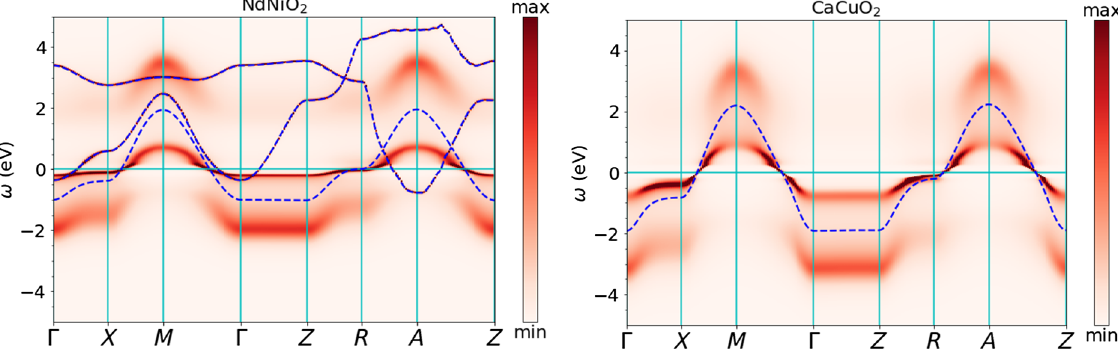
FIG. 4. Frequency dependence of the spectral function A ð k; ω Þ plotted along indicated lines in momentum space (false color), computed from narrow energy window paramagnetic phase DMFT with U ¼ 3 . 1 eV at temperature T ¼ 290 K, along with uncorrelated Wannier bands (dashed blue lines) for NdNiO 2 (left-hand panel) and CaCuO 2 (right-hand